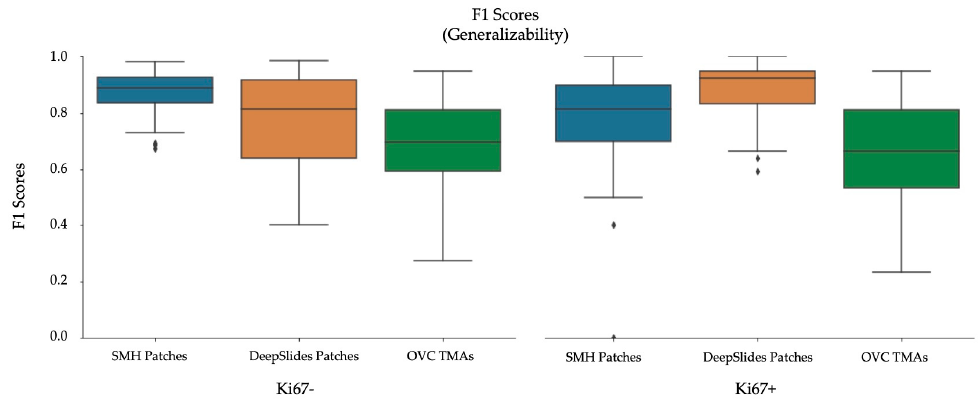
Figure 14. F1 scores on three datasets, SMH patches, DeepSlides, OVC per stain (Ki67 − and